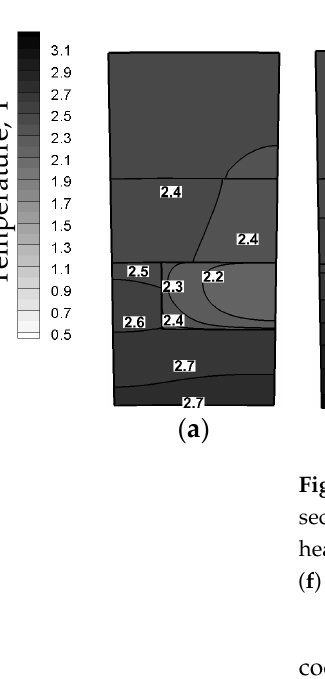
Figure 17. Nominal operating point: dimensionless fields of density, specific heat, thermal conductivity and viscosity at significant transversal slices—fluid zones. Figure 17 integrates the description regarding the behavior of methane inside the cooling jacket through the fields of dimensionless density, specific heat, thermal conductivity, and viscosity. From x/L = 0.61, the fluid core is not only characterized by decreasing values of density but specific heat tends to increase. The highest values in the throat section are attained near the channel surfaces, where relative values of thermal